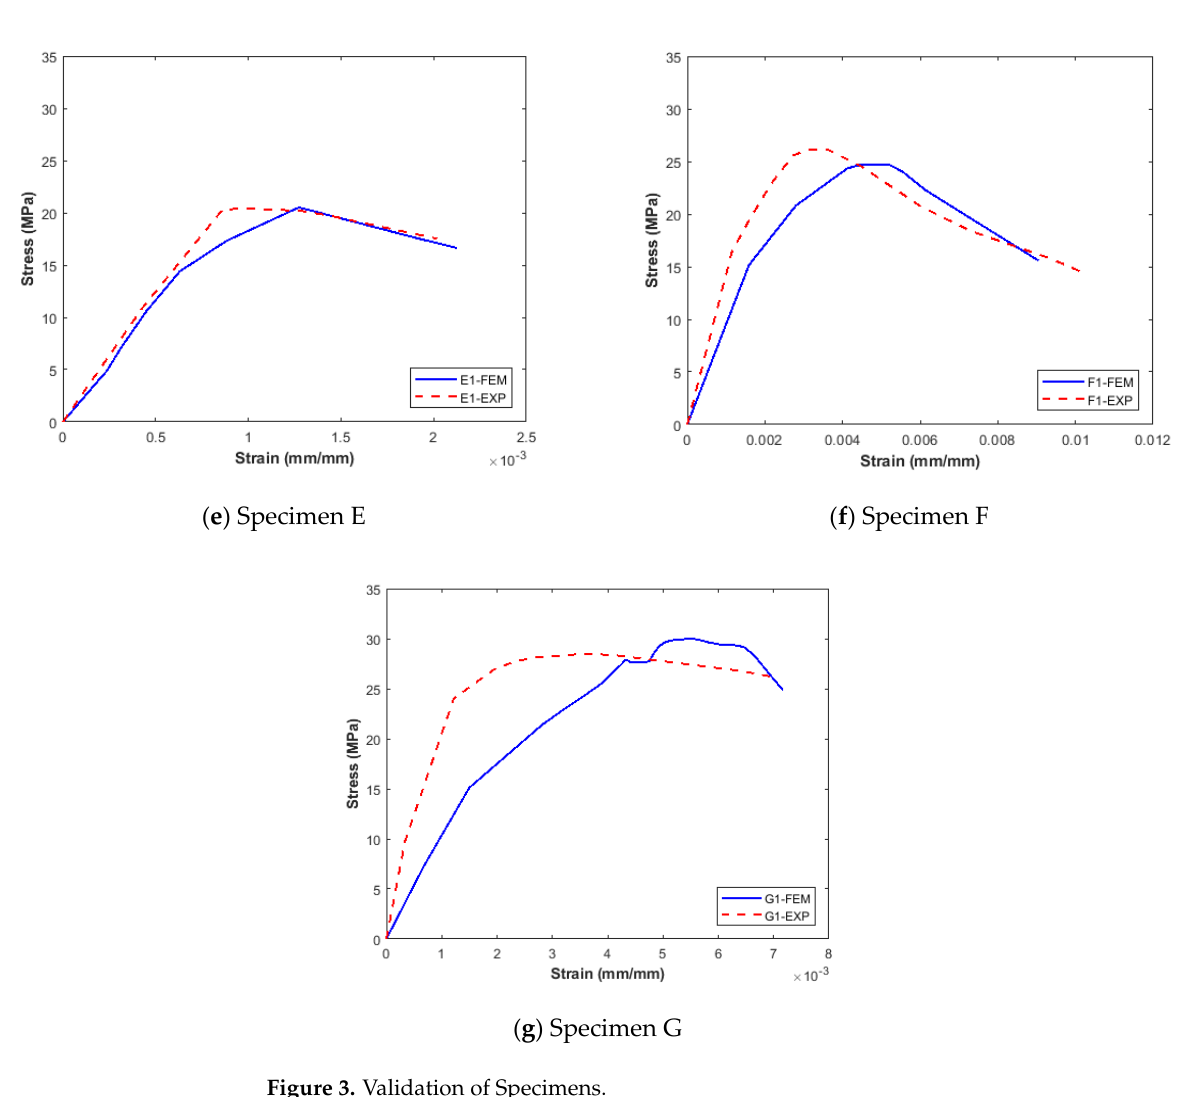
Figure 3. Validation of Specimens. Table 2. Difference Between the Finite Element and Laboratory